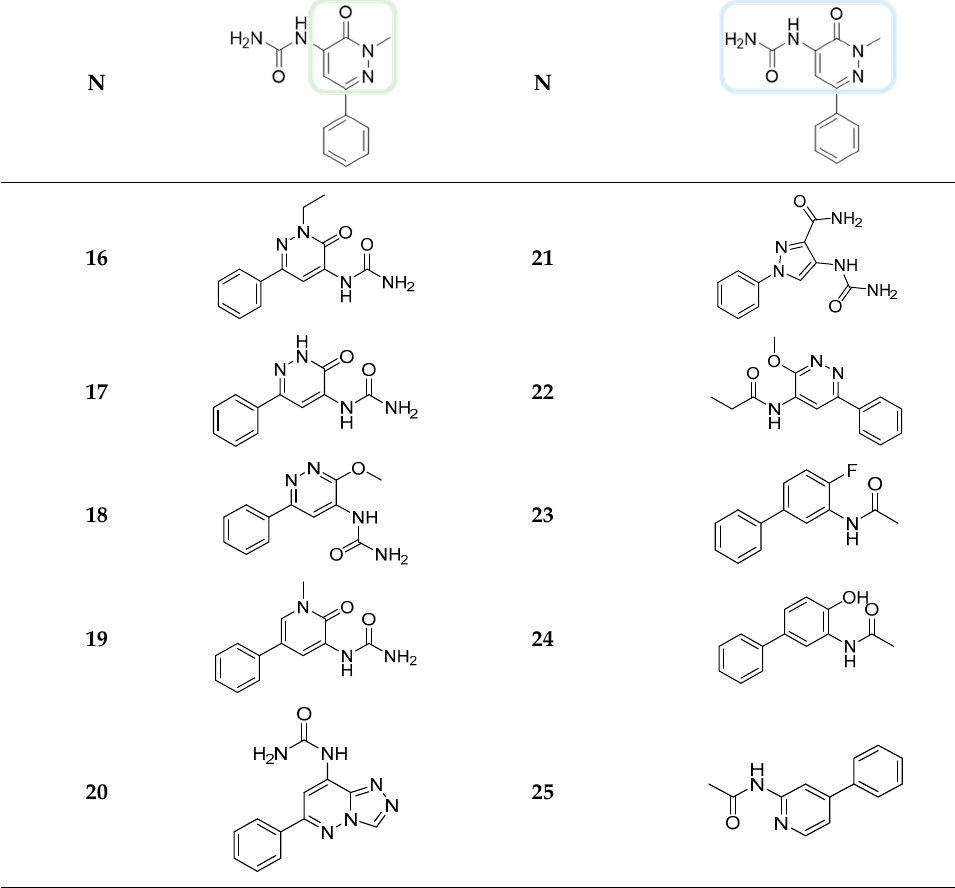
Figure 11. Total energies and F max from SMD experiments (20 Å) for molecules 18 and 22 .